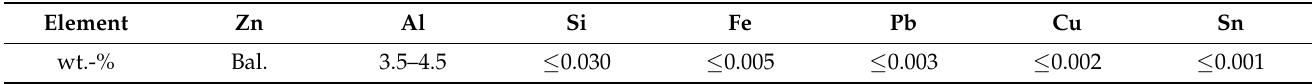
Table 3. Chemical composition of ZnAl4 feedstock wires according to the datasheet of the manufacturer. Element Zn Al Si Fe Pb Cu Sn wt.-% Bal.